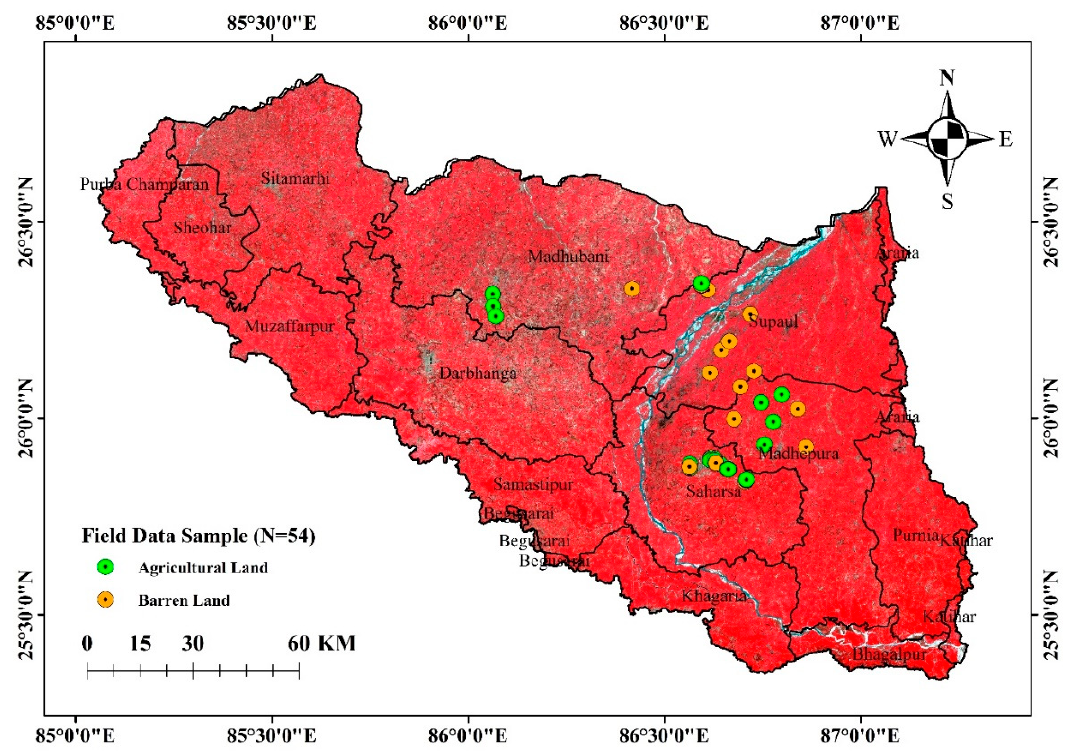
Figure 1. The location of Kosi River Basin in north Bihar, India. The in-situ SSM measurements (N = 54 samples) over agriculture and barren land are overlaid on the False Color Composite (FCC) of Sentinel–2B acquired on 15 February 2021.